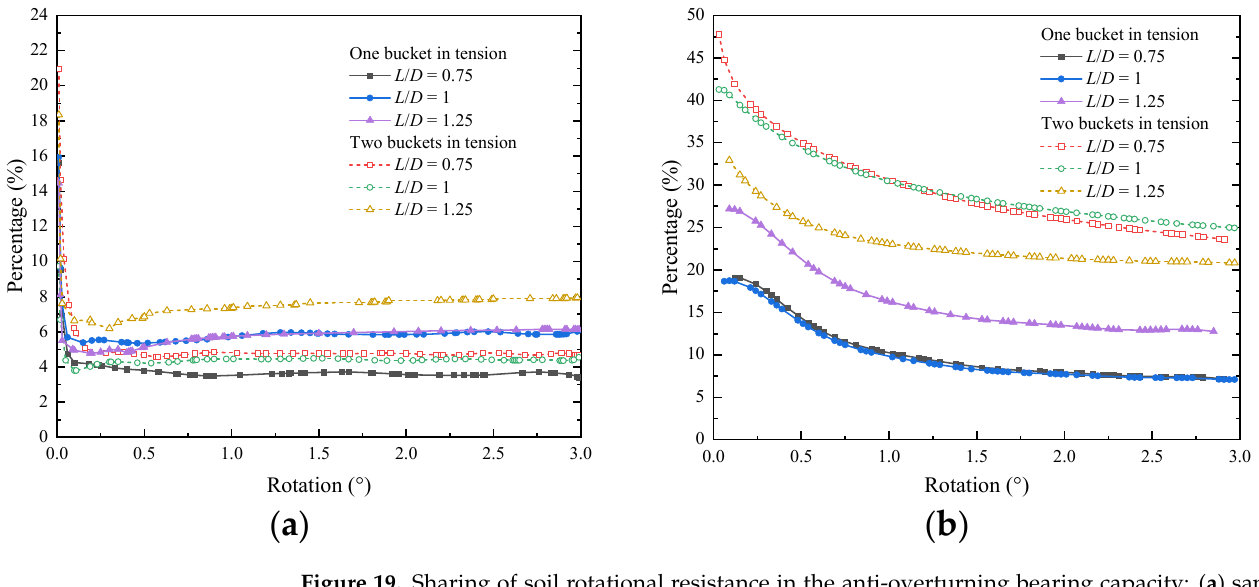
15 of 20 Figure 18. Principle of the soil resistances for tripod foundations under overturning moment. Figure 19a compares the contribution of the rotational resistance of the foundation with varied L / D to the total anti-overturning bearing capacity of the foundation in sandy soil. It can be observed from the fi gure that, at the initial stage of loading, the proportion of the rotational component in the load bearing capacity is relatively large. However, with the increase of the loading moment, the sharing factor of the rotational soil resistance in sand decreases rapidly and remains constant, with li tt le dependence on loading direction and aspect ratio. A similar trend can also be observed in Figure 19b for the tripod bucket a foundation in soft clay. In contrast to sandy soil, the rotational resistance has a substan- tially higher sharing factor for the tripod foundation in soft clay. It implies that the rotat- ing soil resistance brought on by the rotational movement of buckets is what primarily contributes to the anti-overturning bearing capability of the foundation in soft clay. As shown in Figure 19, despite the varied load cases adopted in this paper, the sharing per-